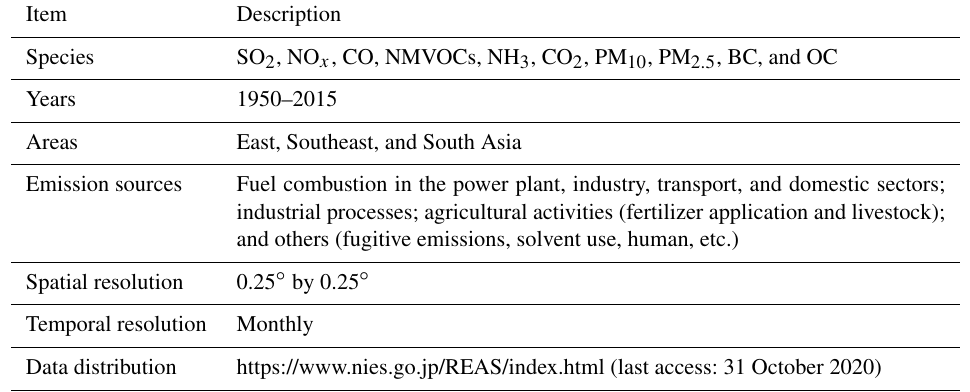
Table 1. General information on REASv3.